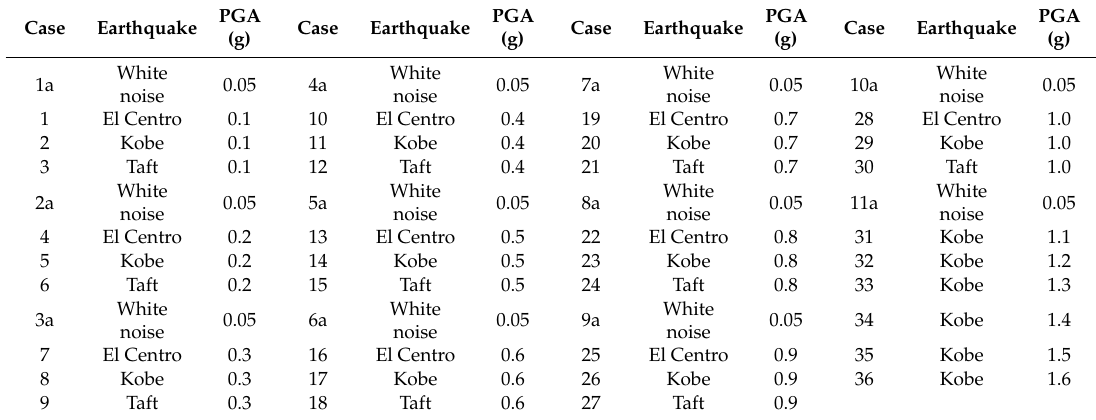
Table 6. Seismic loading plan.